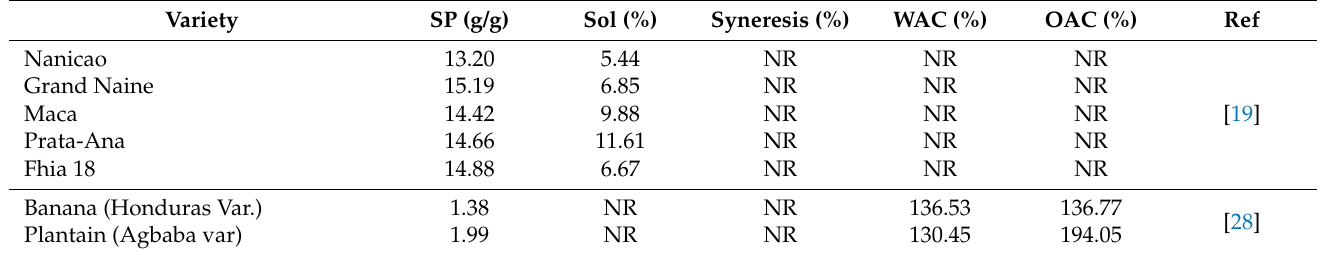
Table 5. Functional properties of banana starch from various